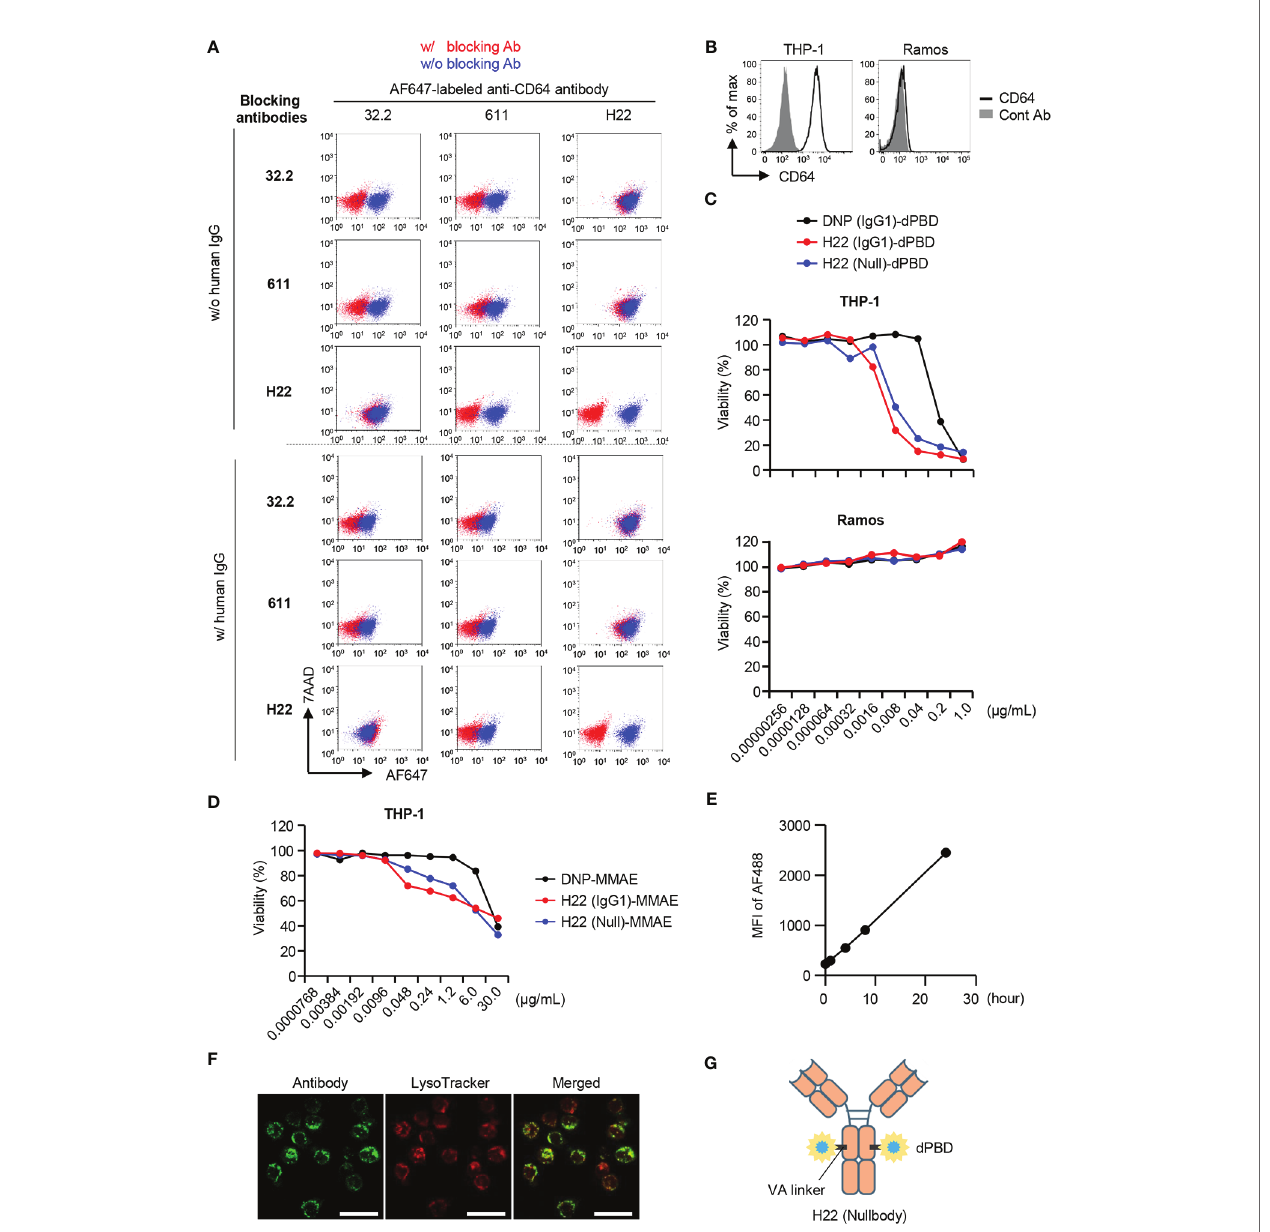
FIGURE 2 | Selection of antibodies and payloads for ADC construction. (A) Competitive inhibition of anti-CD64 antibodies. Three clones of anti-CD64 antibodies (32.2, 611 and H22) were assessed for their capacities of epitope recognition in the presence of other clones. THP-1 cells were pretreated with blocking antibodies and then stained with Alexa Fluor 647 (AF647)-labeled anti-CD64 antibody in the presence or absence of human IgG. To estimate binding capacity, the signal intensity in the presence of the competitors (red dots) was compared with that in the absence of competitors (blue dots). (B) CD64 expression on THP-1 and Ramos cells. (C) Cytotoxicity assays with H22-dPBD. THP-1 and Ramos cells cultured with different ADCs composed of dPBD and an antibody, such as the anti-DNP antibody humanized with IgG1 (DNP(IgG1)-dPBD), H22 humanized with IgG1 (H22(IgG1)-dPBD), or H22 humanized with nullbody, an IgG4 analogue [H22(Null)- dPBD], in the presence of 20% human serum for 4 days. The relative viability of cells was estimated based on the quanti fi cation of ATP. (D) Cytotoxicity assay with H22-MMAE. THP-1 cells were cultured with ADCs composed of MMAE and an antibody, such as the anti-DNP antibody humanized with IgG1 [DNP(IgG1)-MMAE], H22 humanized with IgG1 (H22(IgG1)-MMAE) or H22 humanized with IgG4 nullbody (H22(Null)-MMAE), in the presence of 20% human serum for 4 days. Relative viability was estimated based on the quanti fi cation of ATP. (E) Internalization of H22 nullbody by U937 cells. Cells were pre-cultured with Alexa Fluor 488-labeled H22 antibody for the indicated times. The cells were then incubated with a quenching antibody on ice for 1 h and the signal intensity of Alexa Fluor 488 (AF488) was measured by FCM. (F) Internalization of H22 nullbody into primary monocytes. CD14 hi CD16 - monocytes sorted from peripheral blood were stained with the AF647- labeled H22 nullbody. The cells were then cultured for 23 h after reaction with the H22 nullbody and stained with LysoTracker (100 nM) for 1 h. Cell images were obtained by confocal microscopy. Scale bar, 20 µm. (G) A schematic illustration of the structure of H22-dPBD. Data are representative of two (A – E) or three (F) independent